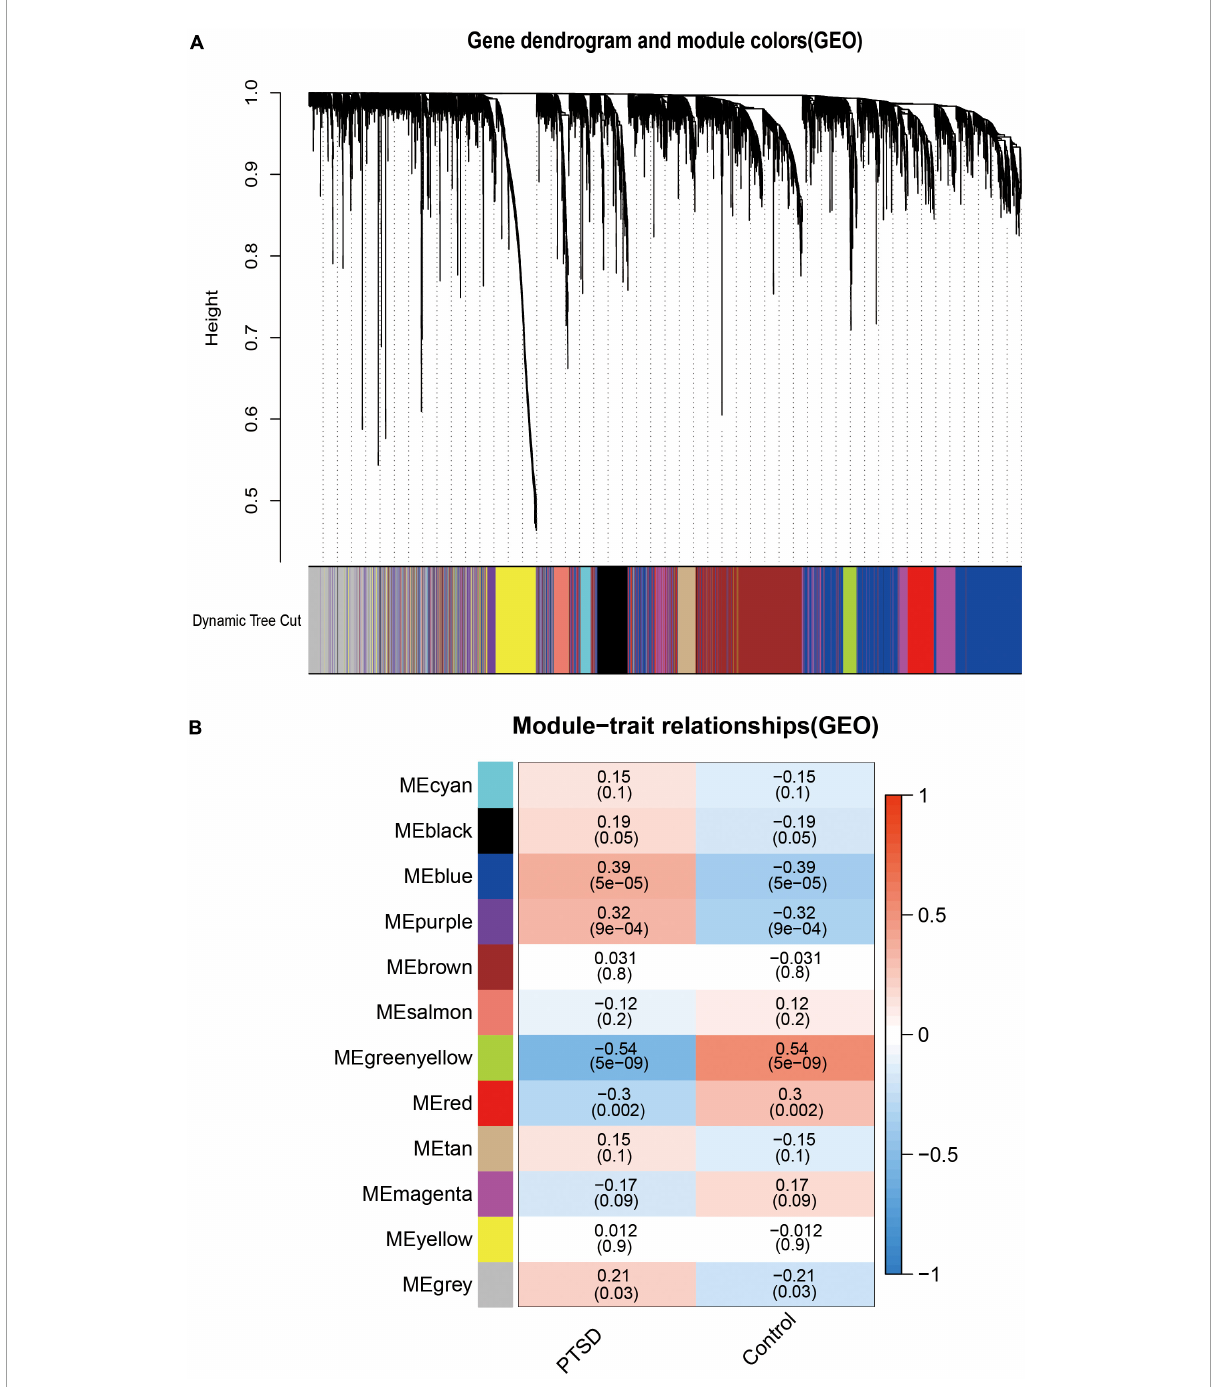
FIGURE7 (A) Through the hierarchical clustering method, similar modules were clustered in 12 module eigengenes (MEs), which summarized all gene expression patterns into a specific module. (B) Spearman’s correlation analysis between the MEs and PTSD indicated that the most relevant object module was MEgreenyellow (correlation coefficient = − 0.54, P = 5e-09).